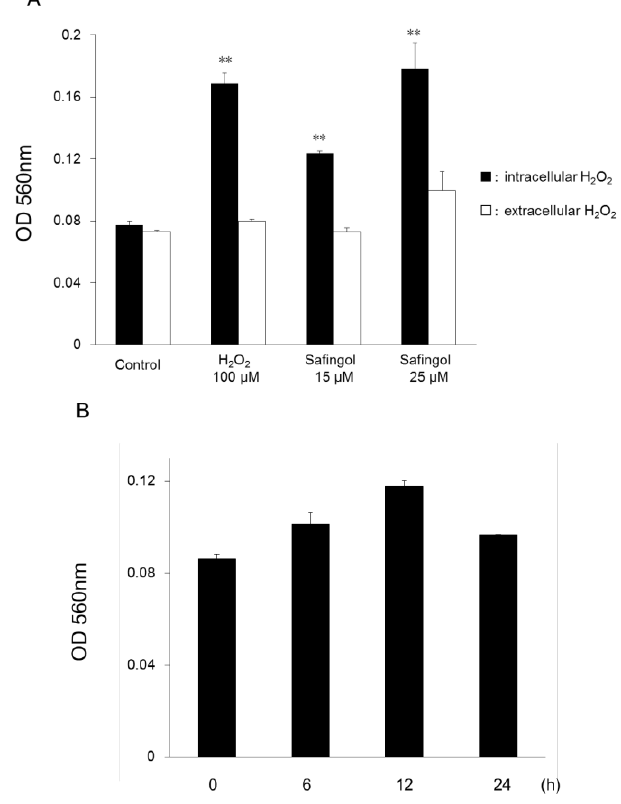
H O or safingol, and extracellular and intracellular ROS levels were determined 12 h later 2 2 ( A ); SAS cells were treated with 15 µM safingol, and intracellular ROS levels were determined 0, 6, 12, 24 h later ( B ). The data represent the mean ± SD of three determinations. ** p < 0.01 vs.